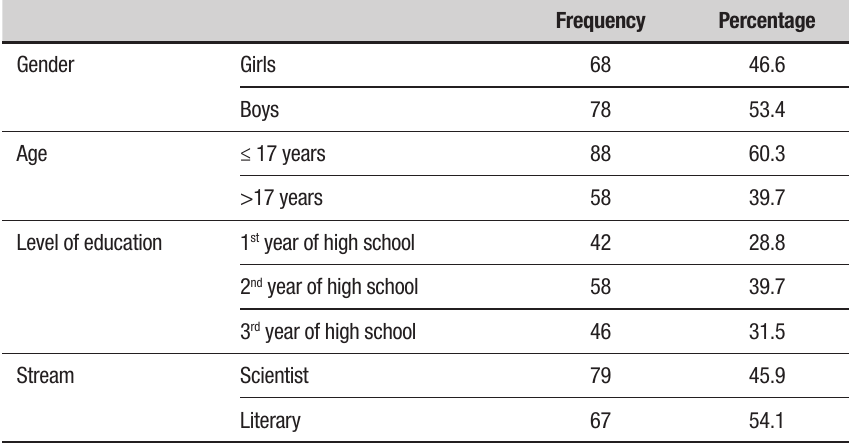
Table 1. Distribution of the sample by gender, age, level of education and